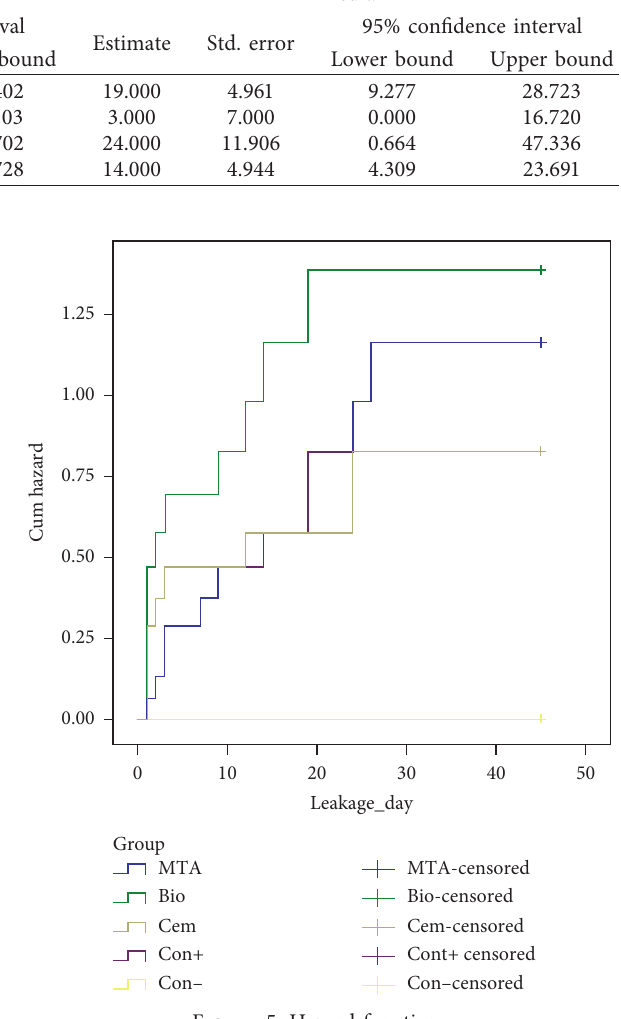
Figure 5: Hazard